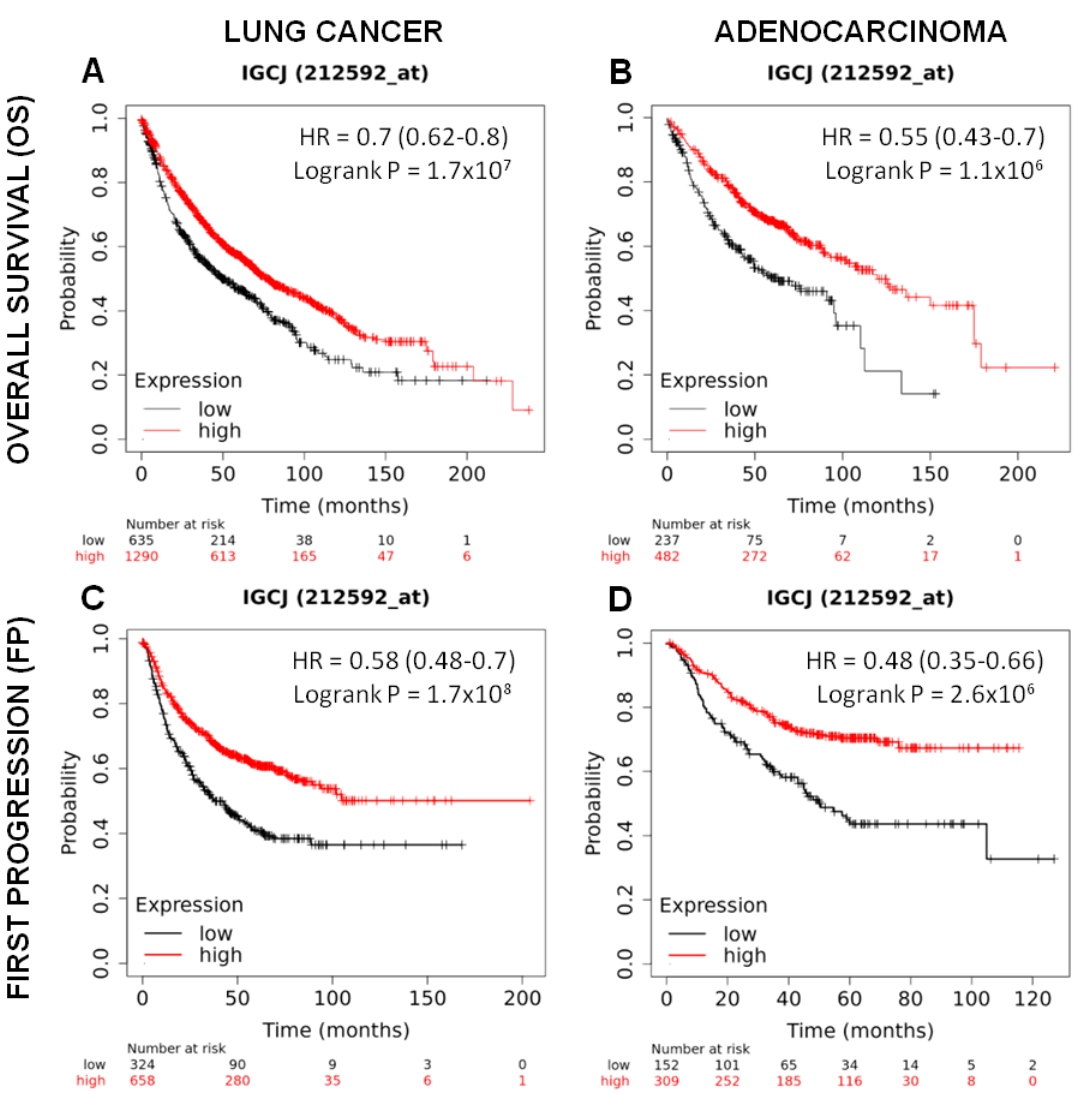
Figure 6. Prognostic significance of J chain expression on lung adenocarcinoma patients. Kaplan– Meier analysis of the prognostic value of J chain mRNA expression in the Kmplot (Affymetrix ID, 212592_at (Gene Symbol: IGCJ)). Overall survival curves plotted for patients with non-small cell lung cancer (n = 1925) ( A ) and with adenocarcinoma histotype (n = 719) ( B ). Time to first progression curves plotted for patients with non-small cell lung cancer (n = 982) ( C ) and with adenocarcinoma histotype (n = 461) ( D ). Cut-off value: lower tertile. HR, hazard ratio (with 95% confidence interval).